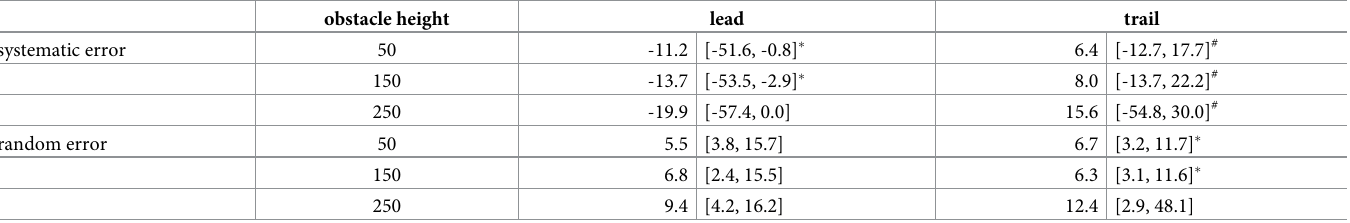
Table 3. Systematic error and random error measured in location B were compared between limbs and obstacle height conditions by using Wilcoxon signed-rank